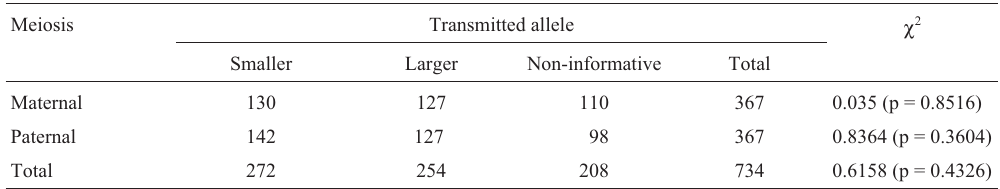
Table 1 - Transmission of larger and smaller SCA1 alleles by normal individuals.